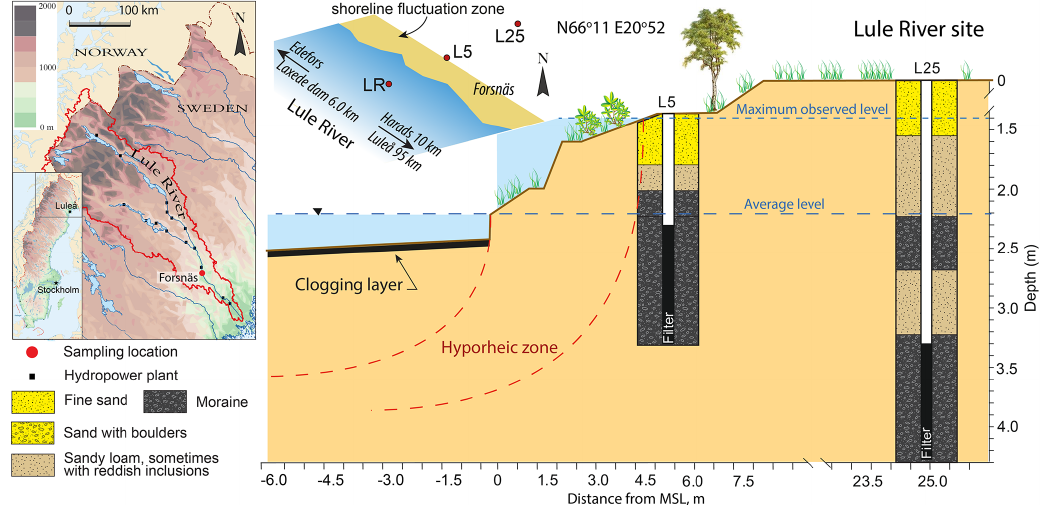
Figure 1. Location of the observation site and cross section of the aquifer with groundwater wells, soil depth profiles and extent of the hyporheic zone. Numbers in well names indicate distance to the mean shoreline in